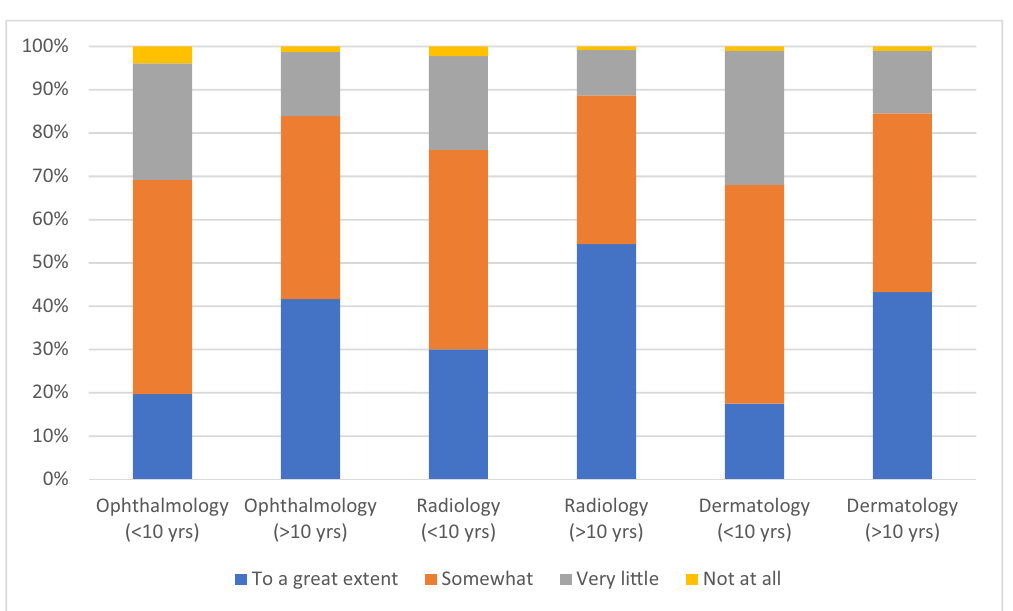
Figure 5. Estimated impact of artificial intelligence on workforce needs within (< 10 years) and beyond (> 10 years) the next decade for each specialty